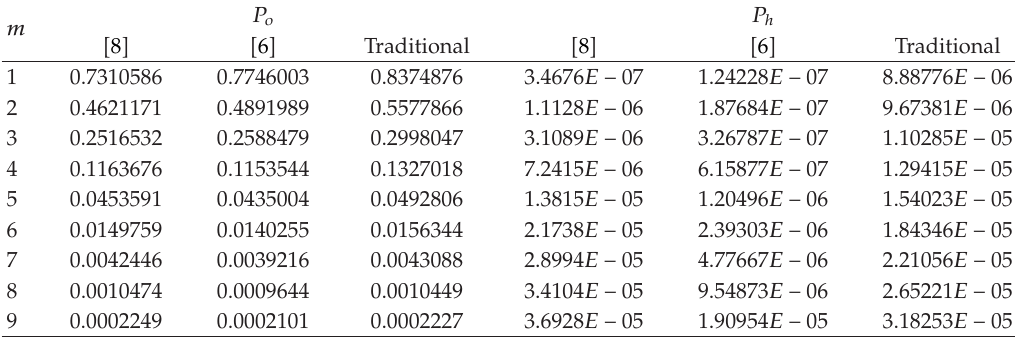
Table 1: Comparison of di ff erent algorithms for the case N (cid:8) 10, λ o (cid:8) 1, λ h (cid:8) 5, μ o (cid:8) 1, μ h (cid:8) 5.